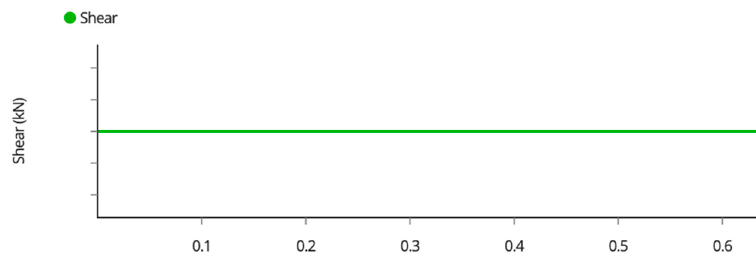
Figure A18. Post shear force diagram.